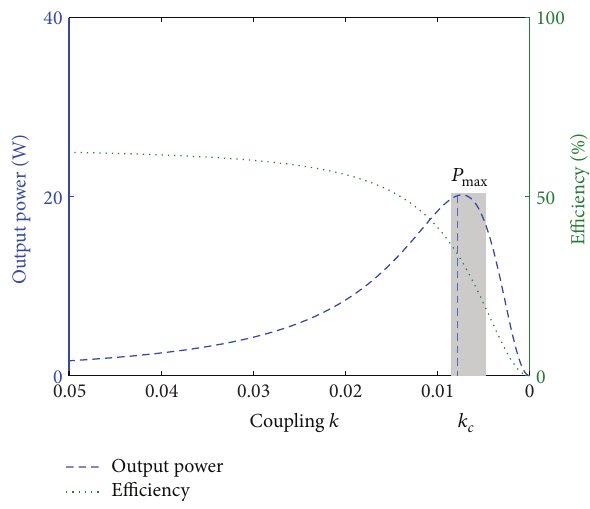
Figure 3: Output power and efficiency when 𝑓 = 𝑓 0